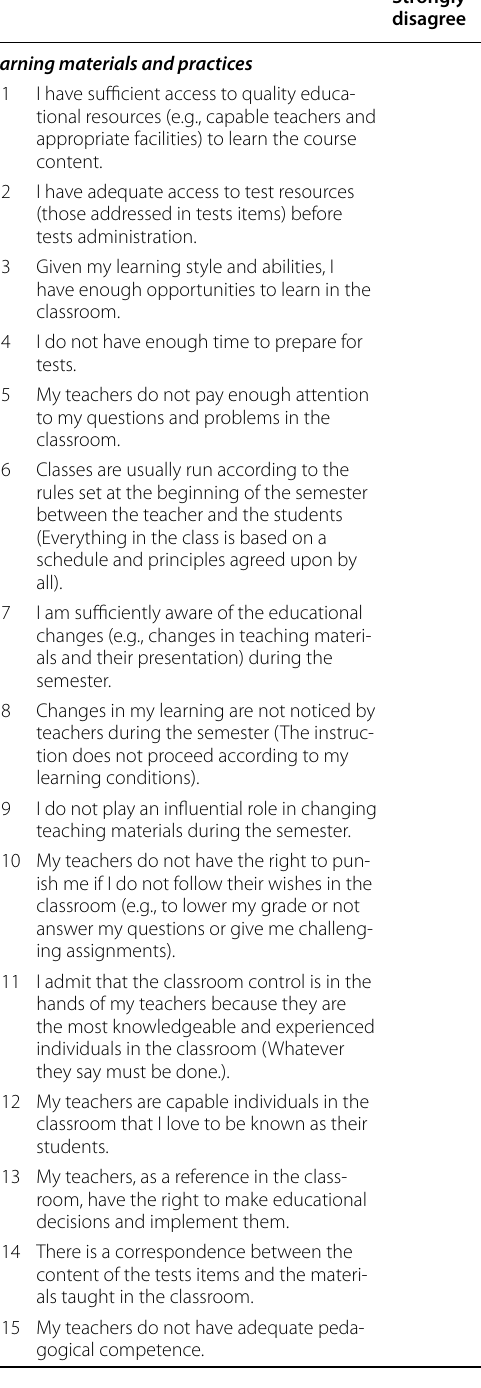
Strongly Disagree Undecided Agree Strongly agree disagree